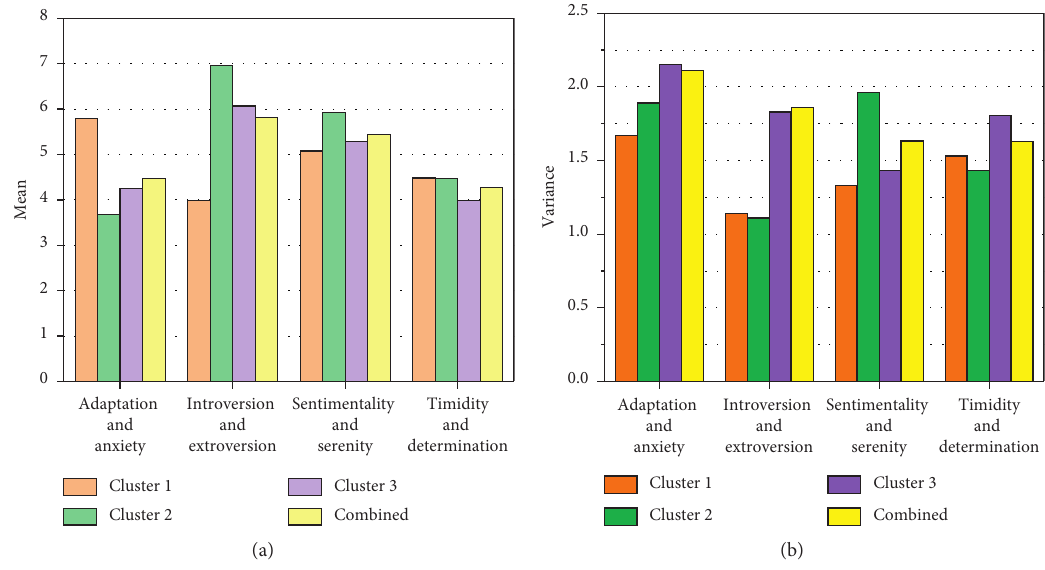
Figure 7: Distribution map of mean difference and variance of each variable in clustering. (a) Distribution of mean. (b) Distribution of